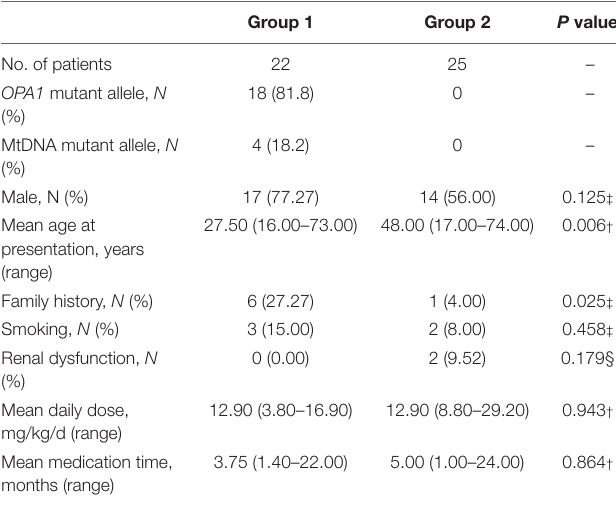
TABLE 2 | Comparison of the demographic and the EMB medication of the two groups of patients. Group 1 Group 2